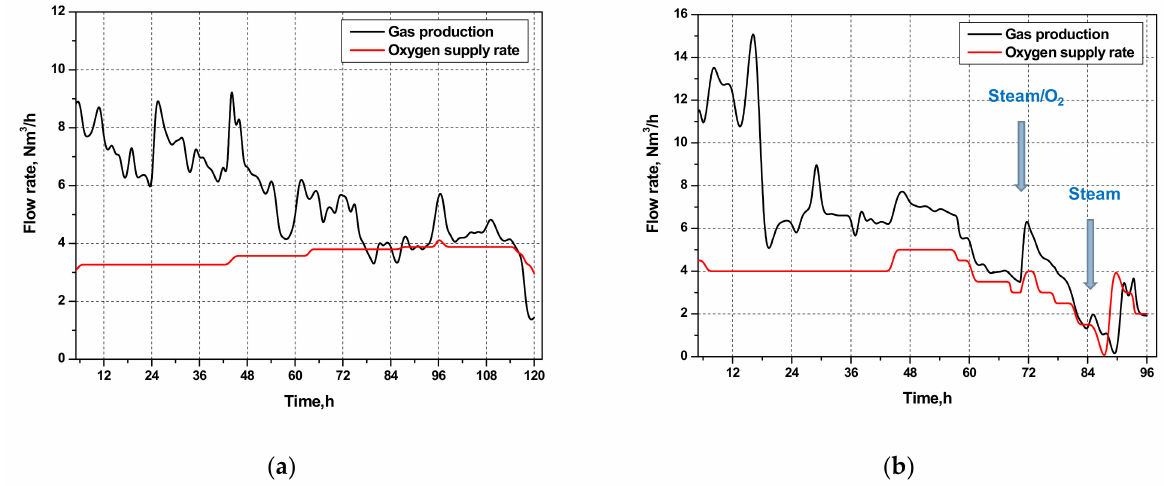
Figure 6. Gas production rates and oxygen supply rates during the UCG experiments: ( a ) Velenje lignite, ( b ) Oltenia